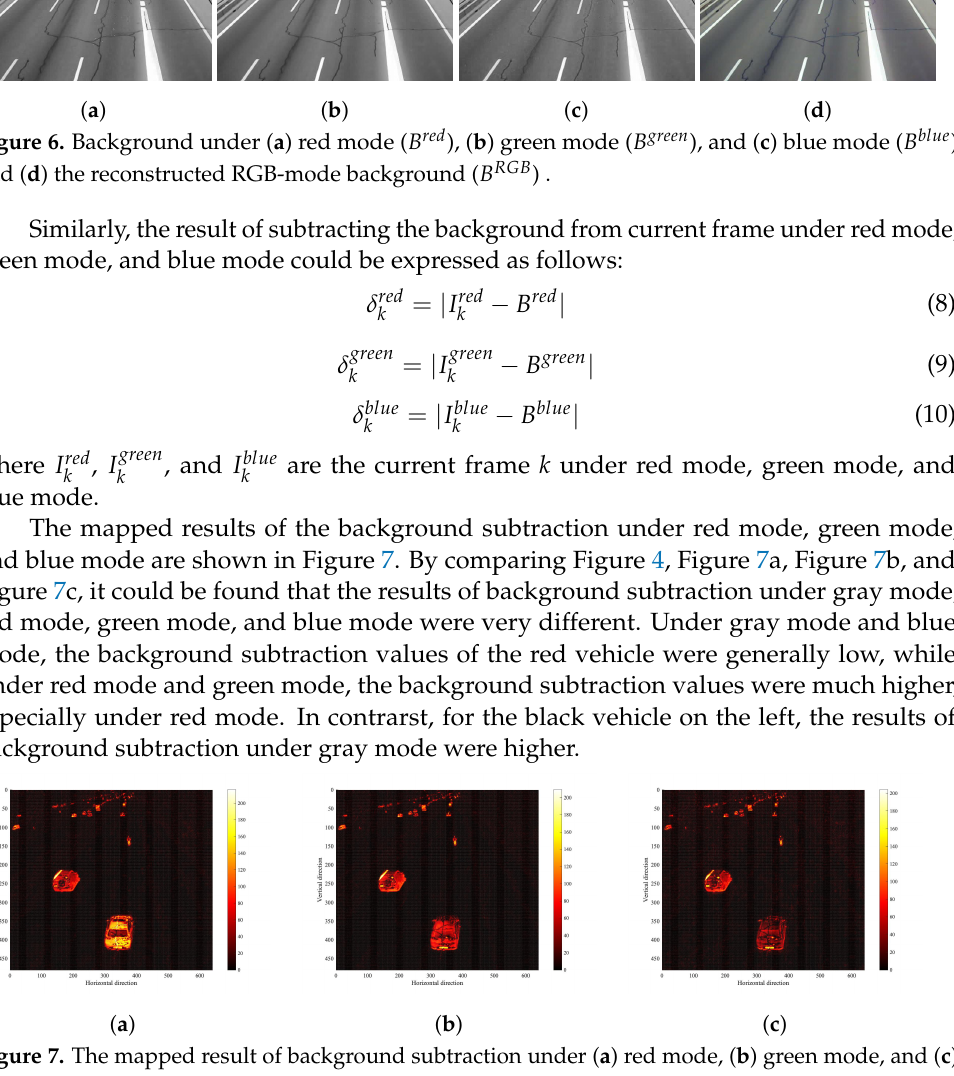
Figure 8. Detection under ( a ) red mode ( I binary red ( I binary blue 539